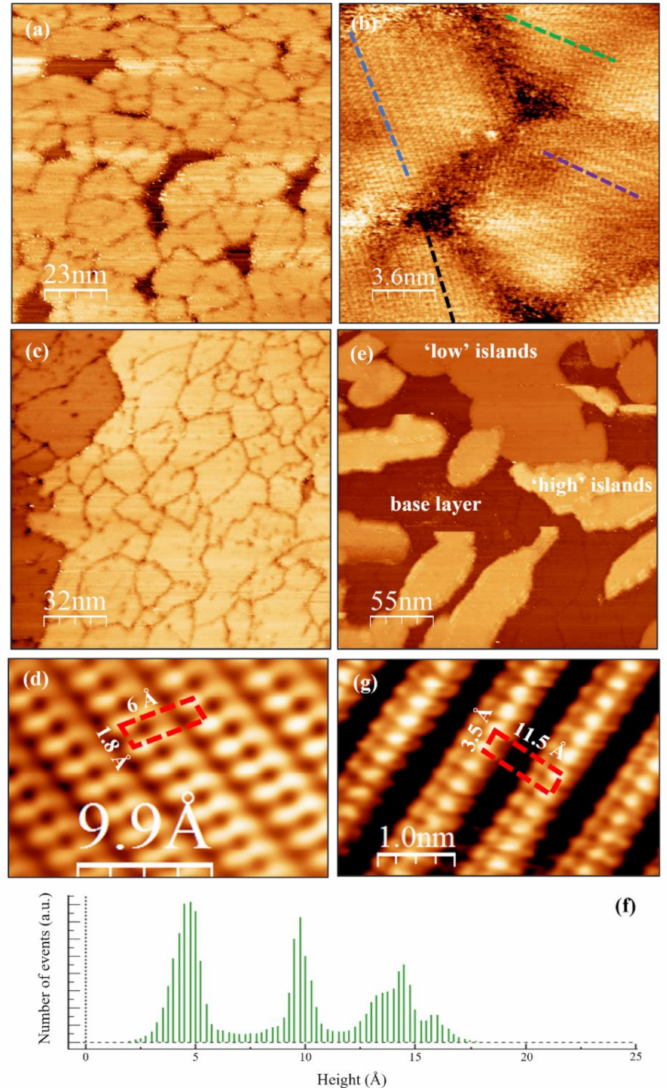
Figure 3. STM characterization of the VO x films after post-annealing. ( a ) Large-scale and ( b ) small- scale topographies of the annealed sample b 2 . Dotted lines indicate the orientation of various domains. ( c ) Large-scale topography and ( d ) atomic-resolution STM image of the annealed sample c 2 . ( e ) Large-scale topography image of the annealed sample d 2 and ( f ) the derived height histogram. ( g ) Atomic-resolution STM image of the ‘high’ islands in ( e ). Atomic-resolution images ( d , g ) are optimized by applying Fourier-transform-filtering. Scanning bias voltage and current are ( a , b ) 0.7 V, 0.6 nA; ( c ) 0.8 V, 0.6 nA; ( d ) 0.8 V, 1.0 nA; ( e ) 0.9 V, 0.6 nA; ( g ) 0.7 V, 0.7 nA,